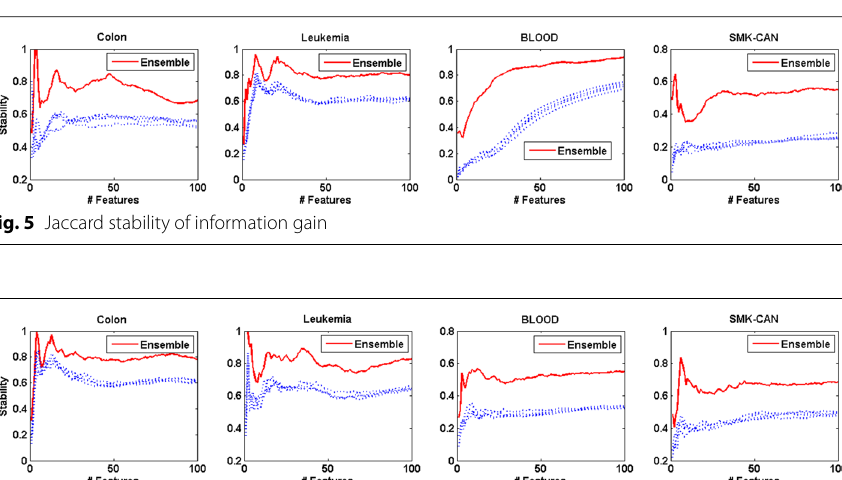
Fig. 6 Jaccard stability of reliefF